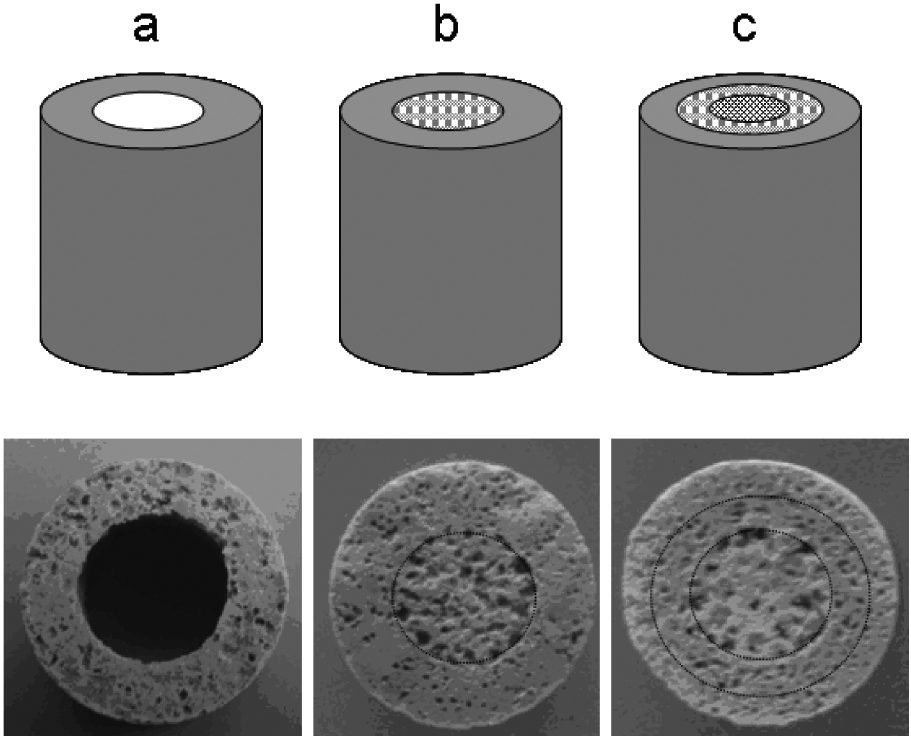
Fig. 4 – Schematic diagrams and photographs of scaffolds with a radial gradient porosity: (a) porous scaffold with a hollow center, (b) two graded porous layers, and (c) three graded porous